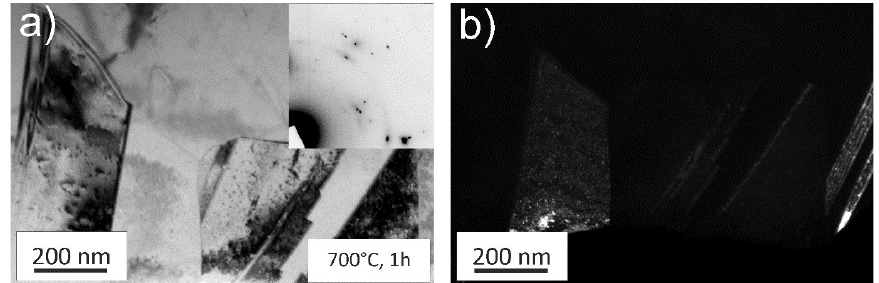
Figure 6. ( a ) TEM image of the microstructure after a 700 °C, 1 h annealing treatment. Grains are no longer in the nanocrystalline (NC) grain size regime and are featuring recrystallization twins. The minority phase can still be found, see ( b ) and inset of ( a ).